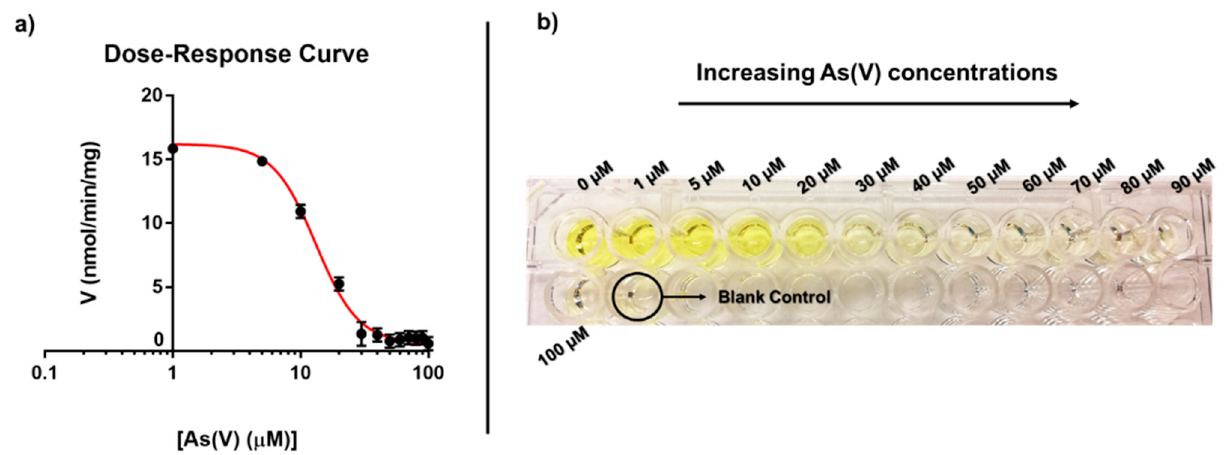
Figure 2. ( a ) Dose-response curve of the inhibition of Tt ArsC phosphatase activity at increasing As(V) concentration was (reported in panel b). ( b ) Tt ArsC phosphatase activity assay in a multiwell plate at increasing concentrations of As(V).